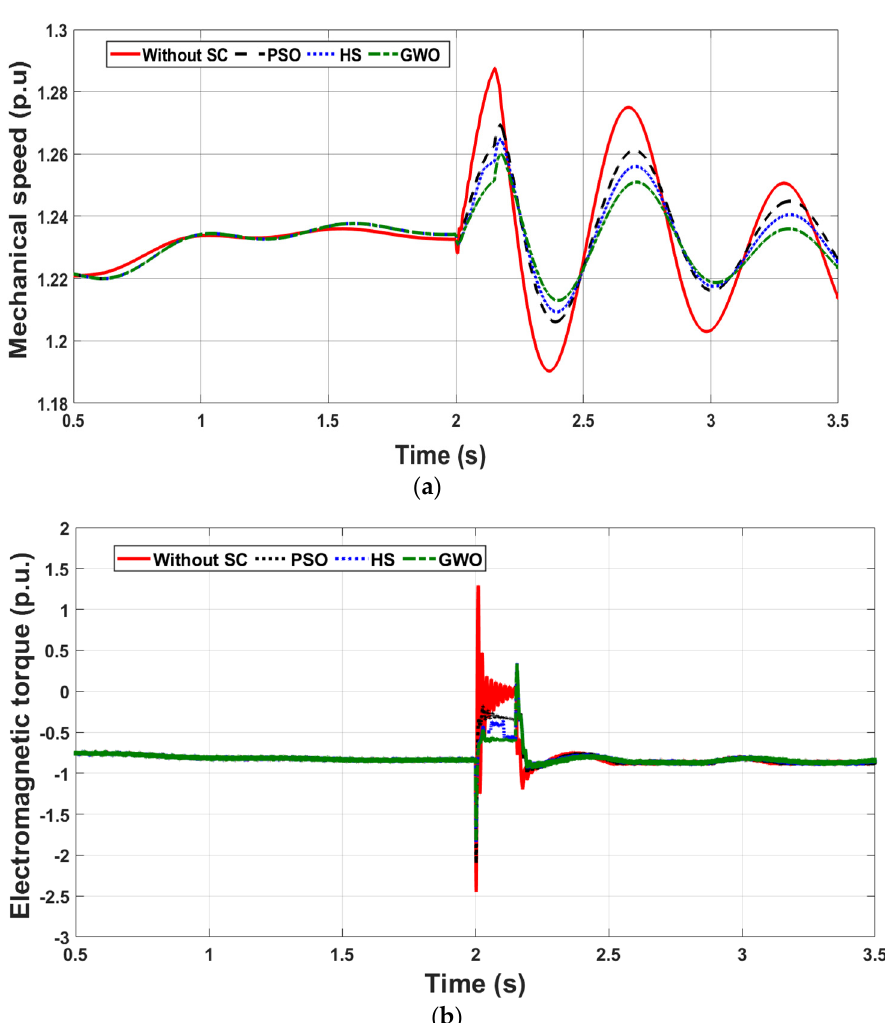
Figure 13. DFIG shaft behavior during the three-phase fault case study: ( a ) shaft speed, ( b ) electro- magnetic torque.